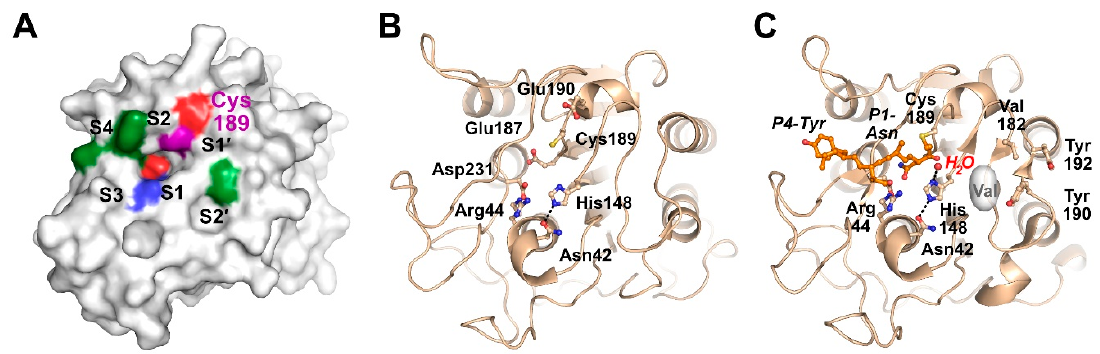
Figure 6. Legumain ligases. ( A ) Human legumain structure as surface representation. The catalytic Cys189 is labeled, as well as the specificity pockets from S4 to S2 ′ (PDB 4AW9). Residues that shape these pockets are colored as hydrophobic (green), basic (blue), and acidic (red). ( B ) Active site of plant γ -legumain from A. thaliana , shown without the so-called LSAM domain (PDB 5NIJ). The catalytic triad of Cys189, His148, and Asn42 is depicted as ball-and-stick models, as well as residues that shape the S1 subsite (Glu187, Asp231, Arg44, while His45 was omitted) and the S1 ′ pocket (Glu190). ( C ) Plant γ -legumain displayed as an acyl intermediate model based on the chloromethyl ketone complex (PDB 5OBT). The P1–Asn is well accommodated by the charged residues in the S1 pocket. The catalytic water is depicted as a red sphere, whereby its hydrolytic reactivity depends on the presence residues such as a Val in the prime side of human legumain. In plant legumains, it can be replaced by a Gly, resulting in a larger hydrophobic region, bordered by Val182, Tyr190, and Tyr192, favoring peptide ligase activity.